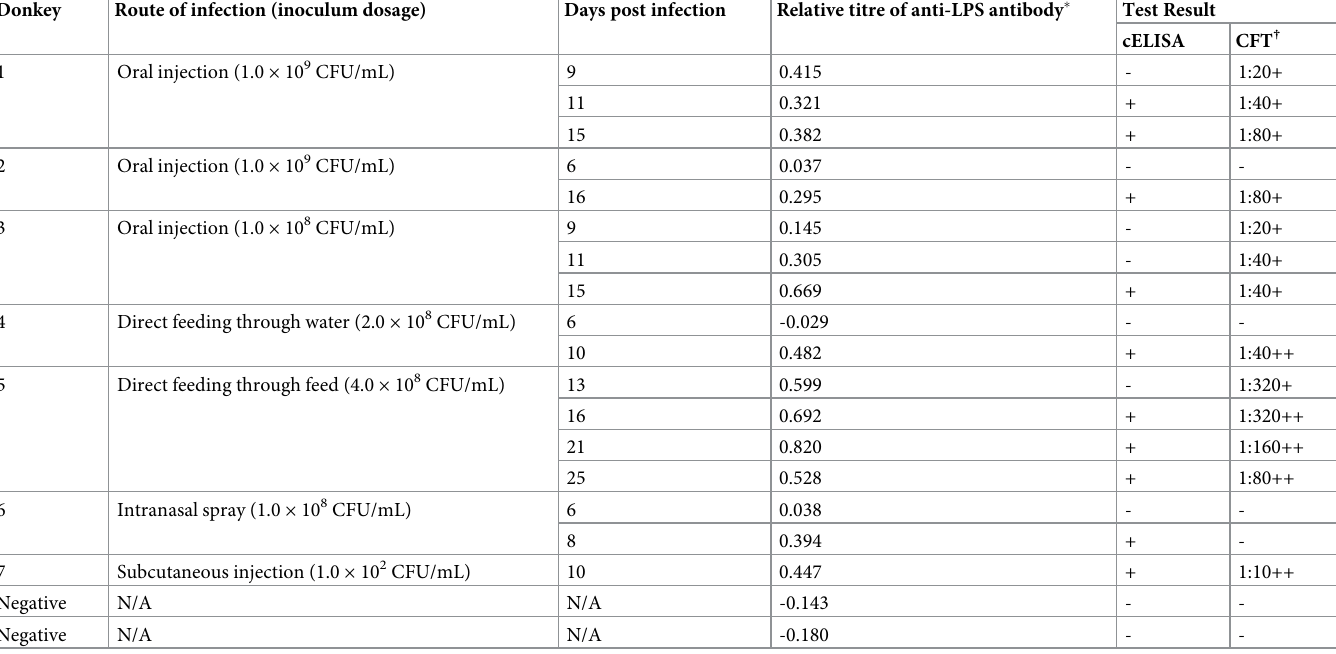
� calculated by a standard curve generated using dilutions of the serum collected on day 21 post infection of donkey 5 † -, 100% hemolysis; +, 25% hemolysis; ++, 50% hemolysis; +++, 75% hemolysis; ++++, 0% hemolysis